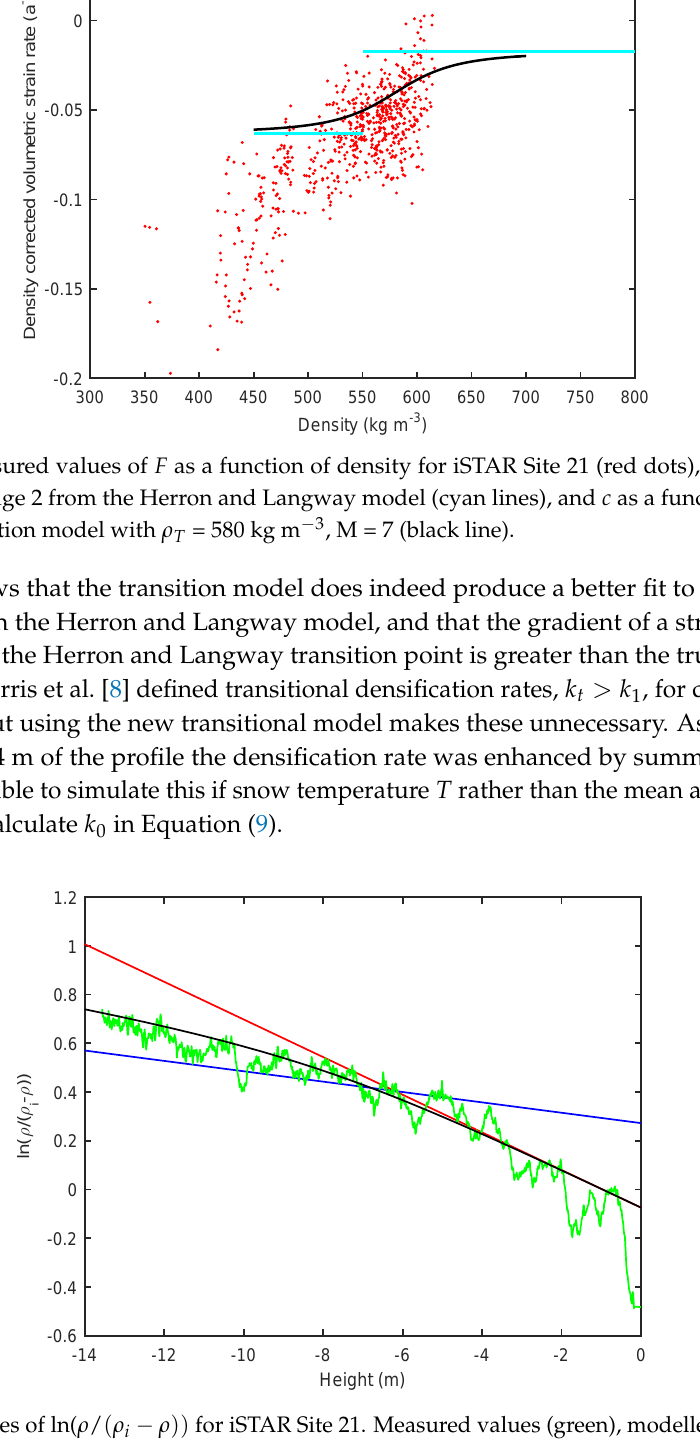
Figure 6. Profiles of ln( ρ / ( ρ i − ρ )) for iSTAR Site 21. Measured values (green), modelled values using Herron and Langway Stage 1 (red) and Stage 2 (blue) densification rates, and modelled values using the transition model with ρ T = 580 kg m − 3 , M = 7 (black